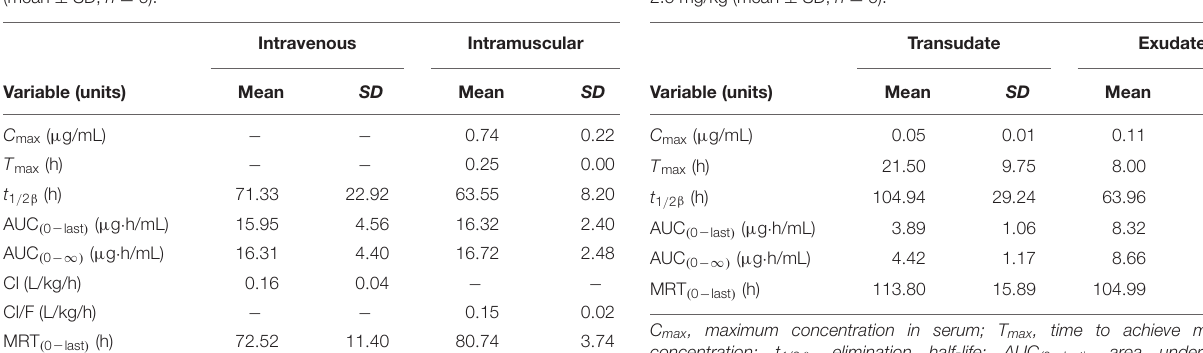
TABLE 3 | The pharmacokinetic parameters (non-compartmental analysis) of tulathromycin in exudate and transudate after i.m. administration at a dosage of 2.5 mg/kg (mean ± SD, n =